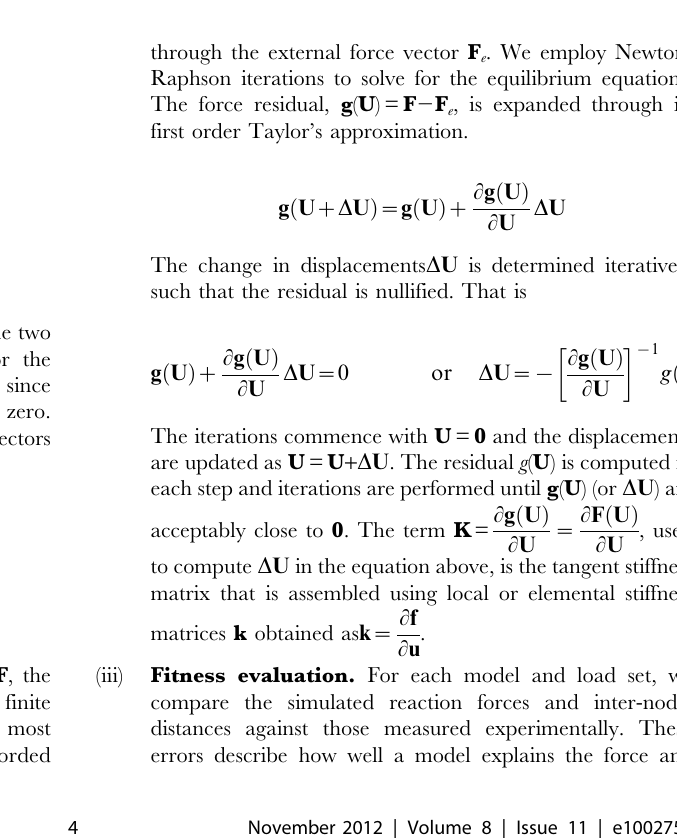
Figure 2. Models are evolved from the primordial mesh of strings in (a). Length of each string behaves as a topological and parametric design variable. For the informative equilibrium configurations that the mesh observes, if some strings remain slack, they are eliminated from the topology. Only taut strings in some or all configurations get retained. Length and cross sections of strings are evolved as design variables. (b) Each taut string in the parent mesh is modeled as a large deformation truss finite element. Slack strings do not support the external loads. Analysis performed is geometrically (for synthetic targets) and materially (for the finger extensor mechanism) nonlinear and equilibrium is achieved through efficient, quadratically convergent Newton-Raphson iterations.